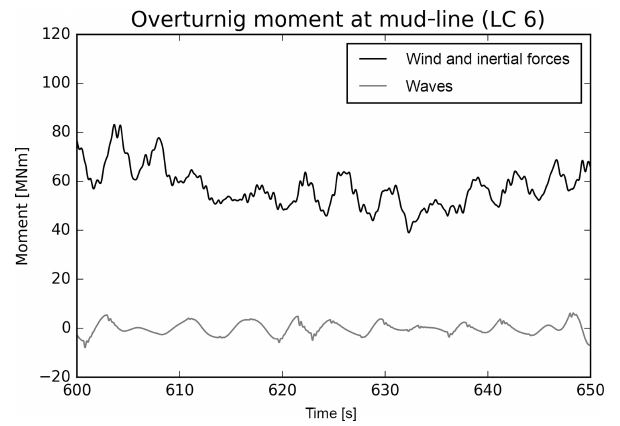
Figure 10. Overturning moment at mud-line from wind and waves from load case